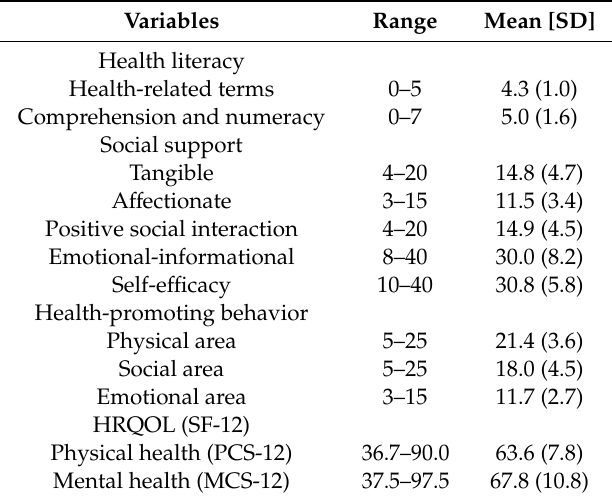
Scores for health literacy, social support, self-e ffi cacy, health-promoting behavior, and health-related quality of life (HRQOL) ( N =